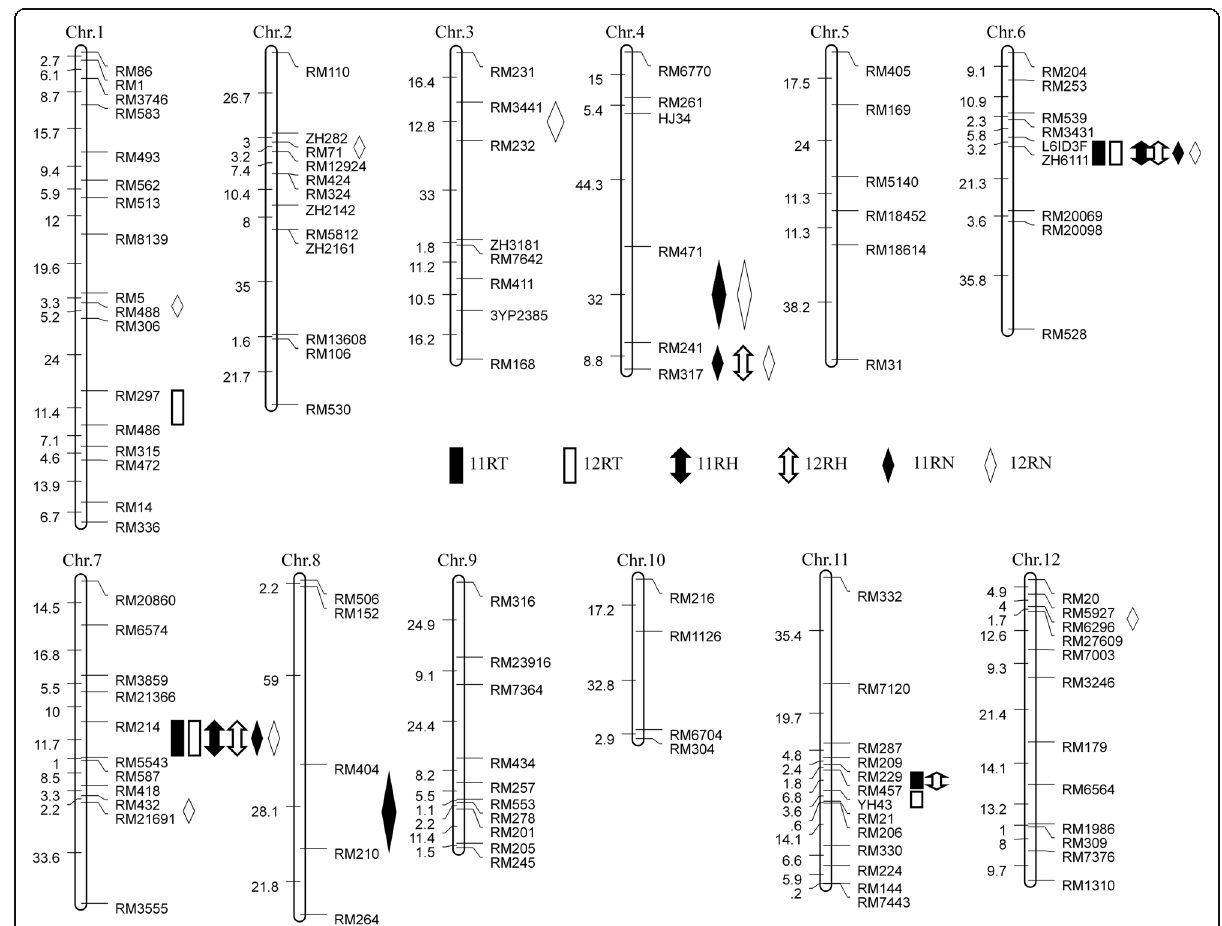
Fig. 4 Distribution of QTLs for blast resistance in the Jin23B/QingGuAi3 population on the genetic linkage map. 11RT and 12RT, leaf blast resistance at tillering stage in 2011 and 2012. 11RH and 12RH, leaf blast resistance at heading stage in 2011 and 2012. 11RN and 12RN, neck blast resistance at maturation stage in 2011 and